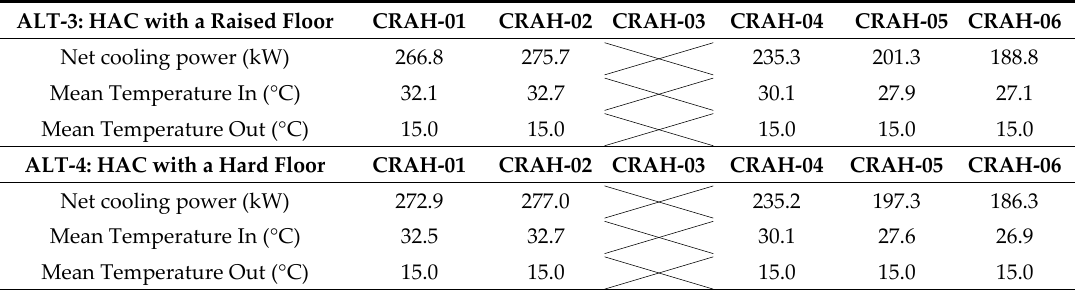
Table 5. Operational net cooling power in cooling fault condition.